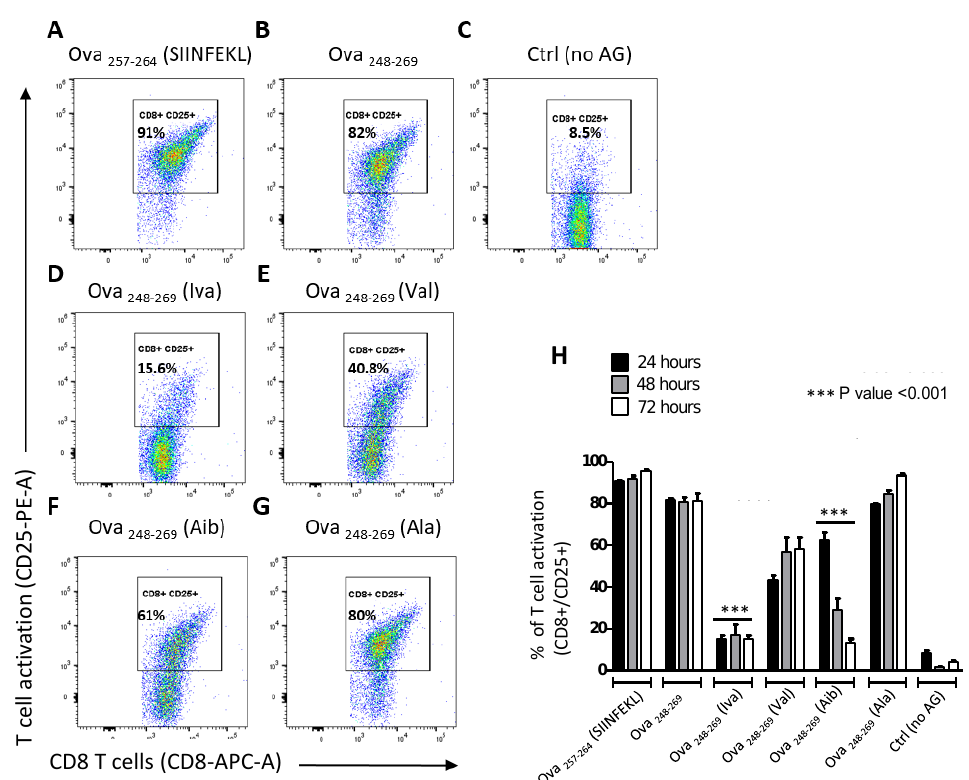
Figure 2. Iva- or Aib containing peptides activate T cells. Cell surface expression of CD25 molecules on OT-I cells following stimulation with peptide antigens. ( A – G ) representative flow cytometry dot plots show CD8 T cell activation after 24 h stimulated with either the native ova-control peptides (( A ): short Ova 257-264 (SIINFEKL) or ( B ): longer Ova 248-269 ), unstimulated ( C ) or with the ova peptides substituted with exo amino acids ( D ): Ova 248-269 (Iva) and ( F ): Ova 248-269 (Aib) or peptides substituted